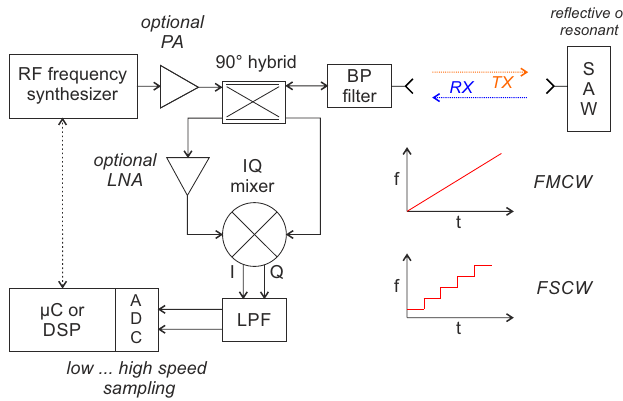
Figure 3. Block diagram of a monostatic reader concept for frequency domain sampling with frequency modulated continuous wave (FMCW) or frequency stepped continuous wave (FSCW)